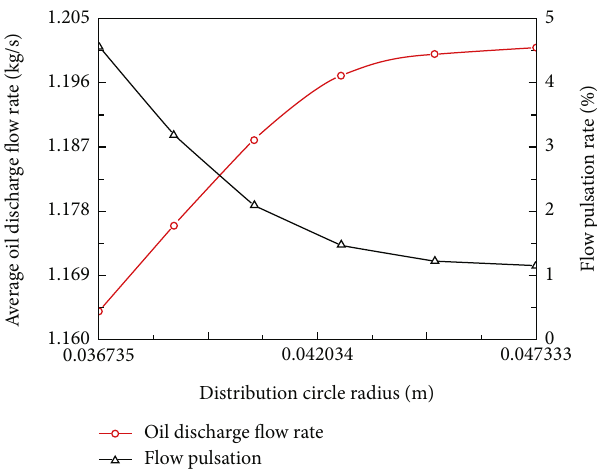
Figure 16: The average oil discharge fl ow rate curve and fl ow pulsation curve with di ff erent distribution circle radii and rotation